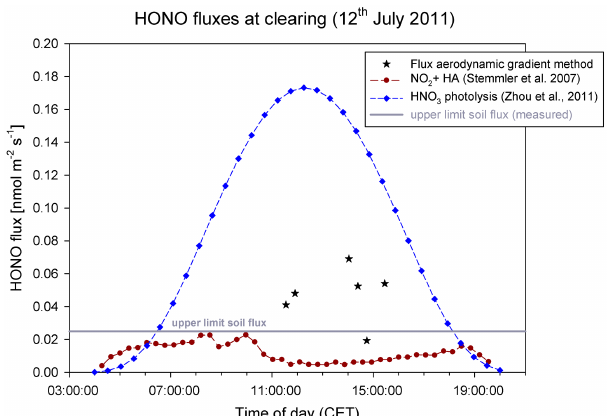
Figure 6. Comparison of measured HONO fluxes at the clearing on 12 July 2012 with estimates of potential HONO sources. Black stars represent the fluxes derived from the aerodynamic gradient method. Blue diamonds are HONO fluxes calculated from the measured ni- trate loadings according to Zhou et al. (2011) but using the geo- metric needle area (see Sect. 3.4.3, approach 2). Brown dots are calculated HONO fluxes according to Stemmler et al. (2007) as- suming a flat surface covered with humic acid. The grey horizontal line marks the upper limit of soil HONO fluxes derived from labo- ratory dynamic chamber